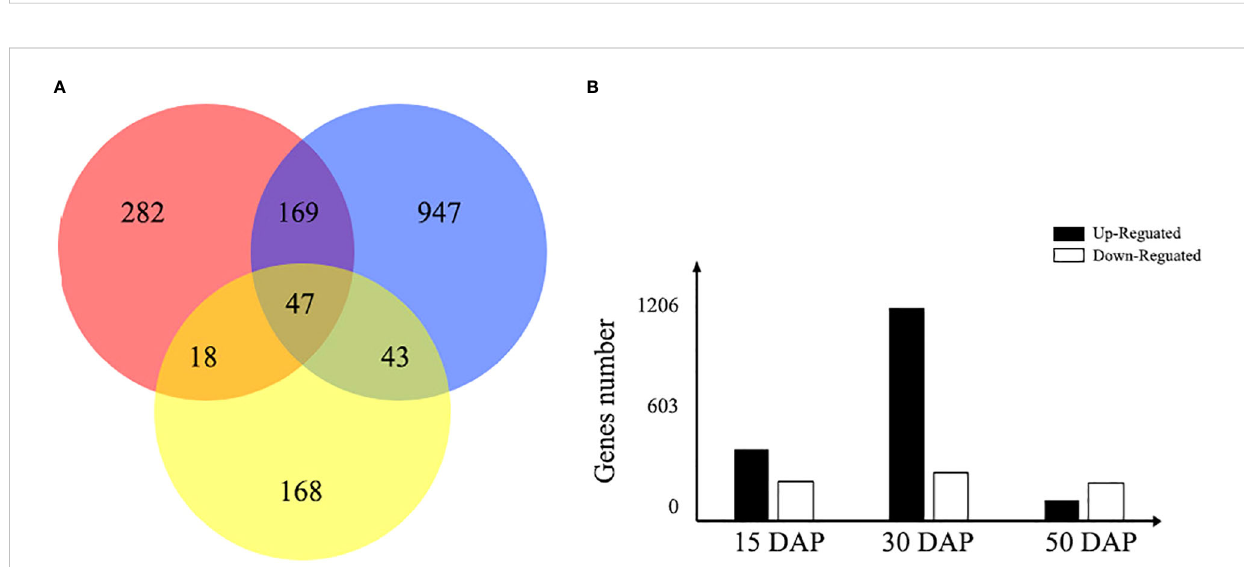
FIGURE 4 Venn diagram of the number of DEGs expressed during seed development. (A) The red, blue, and yellow circles represent the early, middle, and late stages of seed development, respectively. The number represents the number of DEGs between yellow- and black-seeded rapeseed. (B) The bar chart shows the total number of DEGs expressed during early (15 DAP), middle (30 DAP), and late (50 DAP) seed development. Black bars indicate upregulated DEGs in yellow seeds, and white bars indicate downregulated DEGs in yellow seeds.